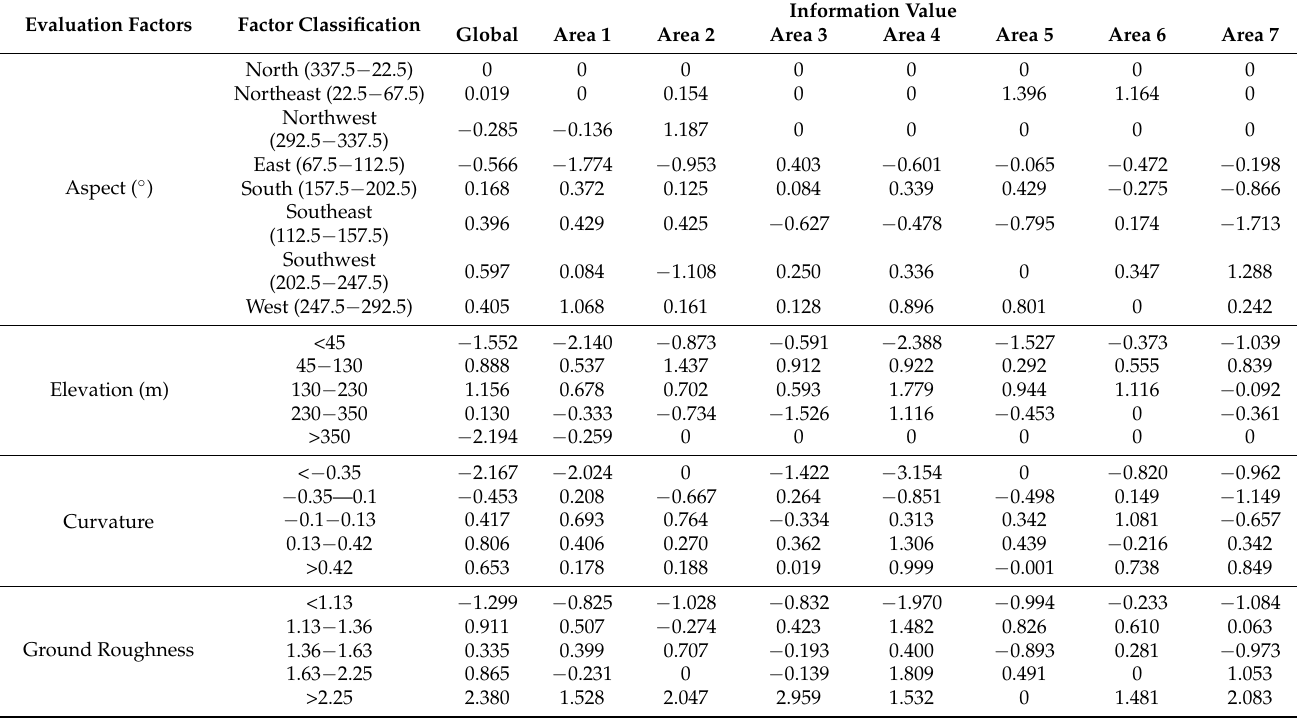
Table 3. Global and regional information value of each evaluation